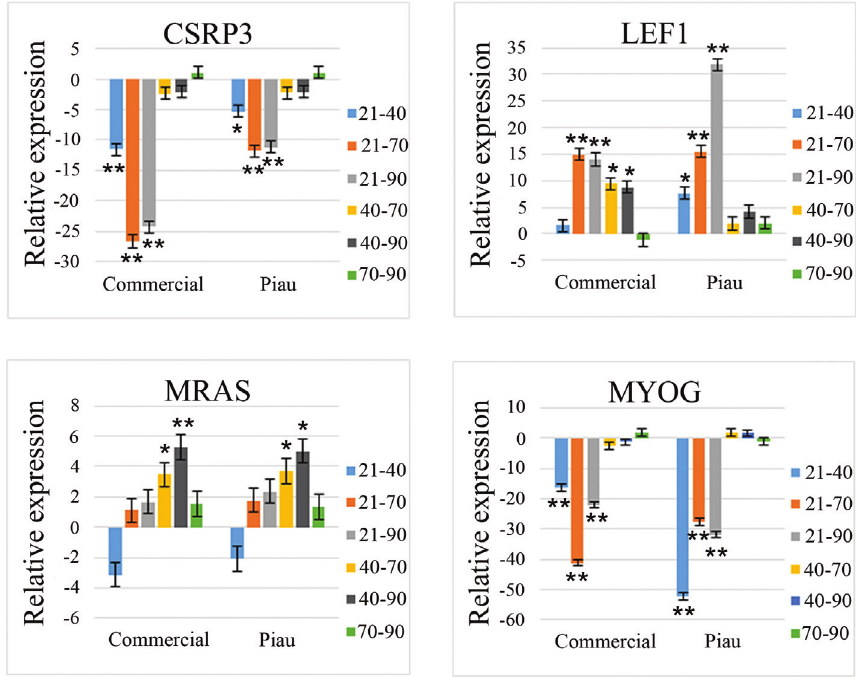
Figure 3 - Relative expression for four genes (CSRP3, LEF1, MRAS and MYOG) in pair-wise comparisons of prenatal ages (21, 40, 70 and 90 days post-insemination) in commercial and Piau pigs. These genes showed a significant interaction for Breed x Period (p < 0.05, F-test in ANOVA). *p < 0.05 and**p<0.01indicatessignificantpair-wisecomparisonsbyStudent’s t -test.Apositivefold-changemeansthatthefirstperiodinthecomparisonshows greater expression than the second period. Negative fold-change means that the second period in the comparison presents greater expression than the first